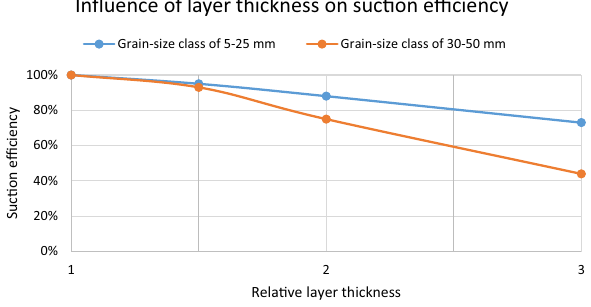
Fig. 6 Suction efficiency with respect to the relative layer thickness of the feed